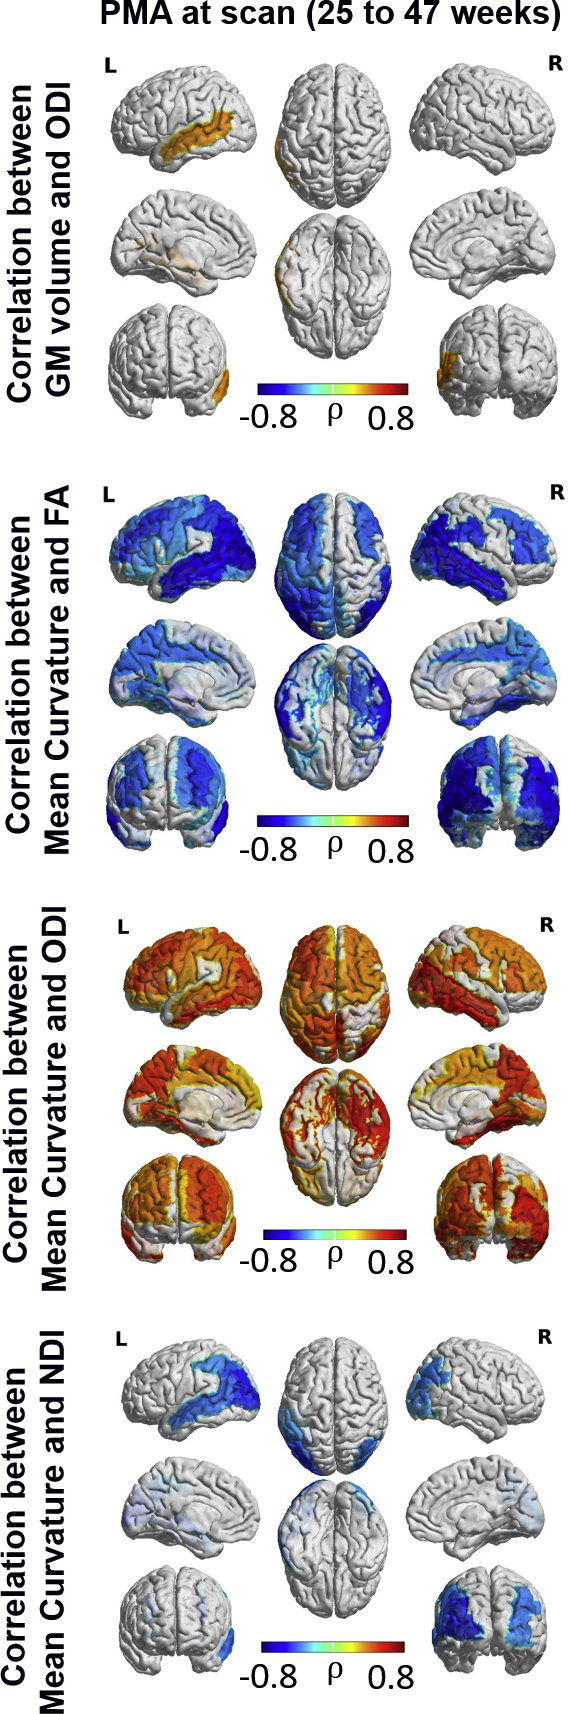
ROI-wise Spearman partial correlation between macrostructural and microstructural features (correcting for all covariates, including PMA at scan, FDR corrected at 5%).